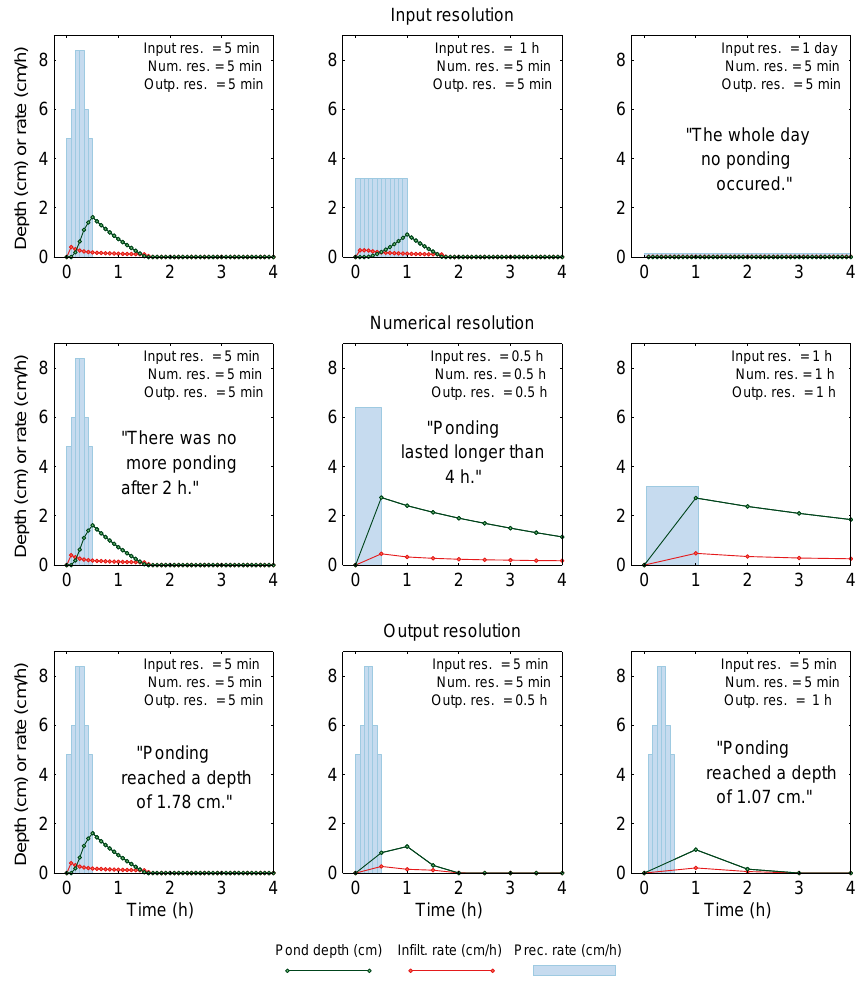
Figure 2. Application of the Green–Ampt infiltration scheme for different input resolutions (upper row), different numerical resolutions (middle row), and different output resolutions (lower row). For each set-up, the model was fed with the same extreme precipitation event of 32mm of rain in 30min (4mm in first 5min, 5mm in 5–10min, 7mm in 10–20min, 5mm in 20–25min and 4mm in 25–30min). The model parameters have been kept constant; saturated hydrologic conductivity K s = 0 . 044cmh − 1 , initial soil moisture θ i = 0 . 1, saturated soil moisture θ s = 0 . 5, matric pressure at wetting front (cid:57) = 22 . 4cm. Each of the three time concepts impacts the conclusions that are drawn from the model results, which shows that calibration and validation at the appropriate time interval is essential to resolve the processes taking